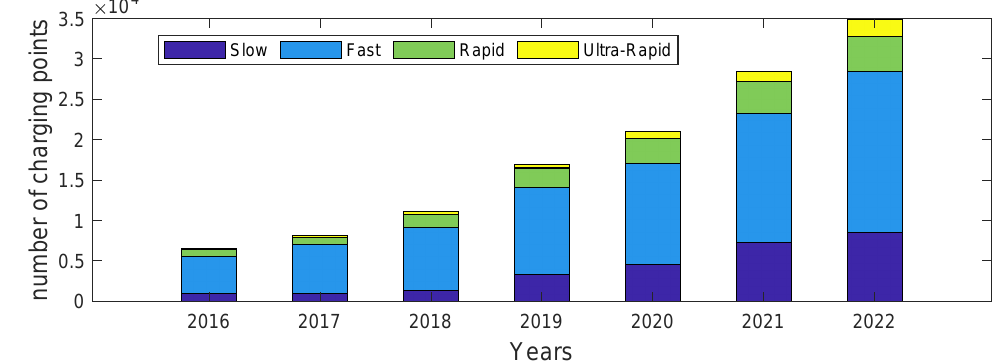
Figure 7. Number of public charging points in the UK [38].